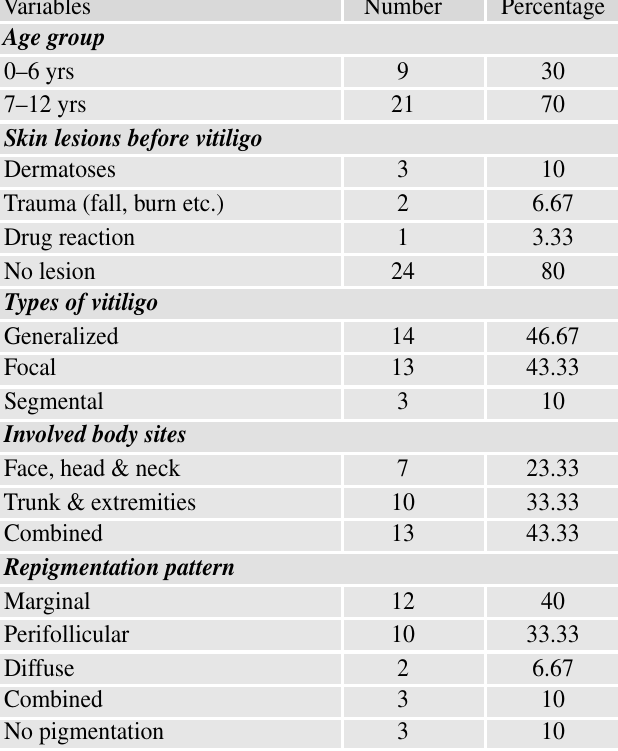
Table I: Distribution of the study patients by age, skin lesions before developing vitiligo, types of vitiligo,